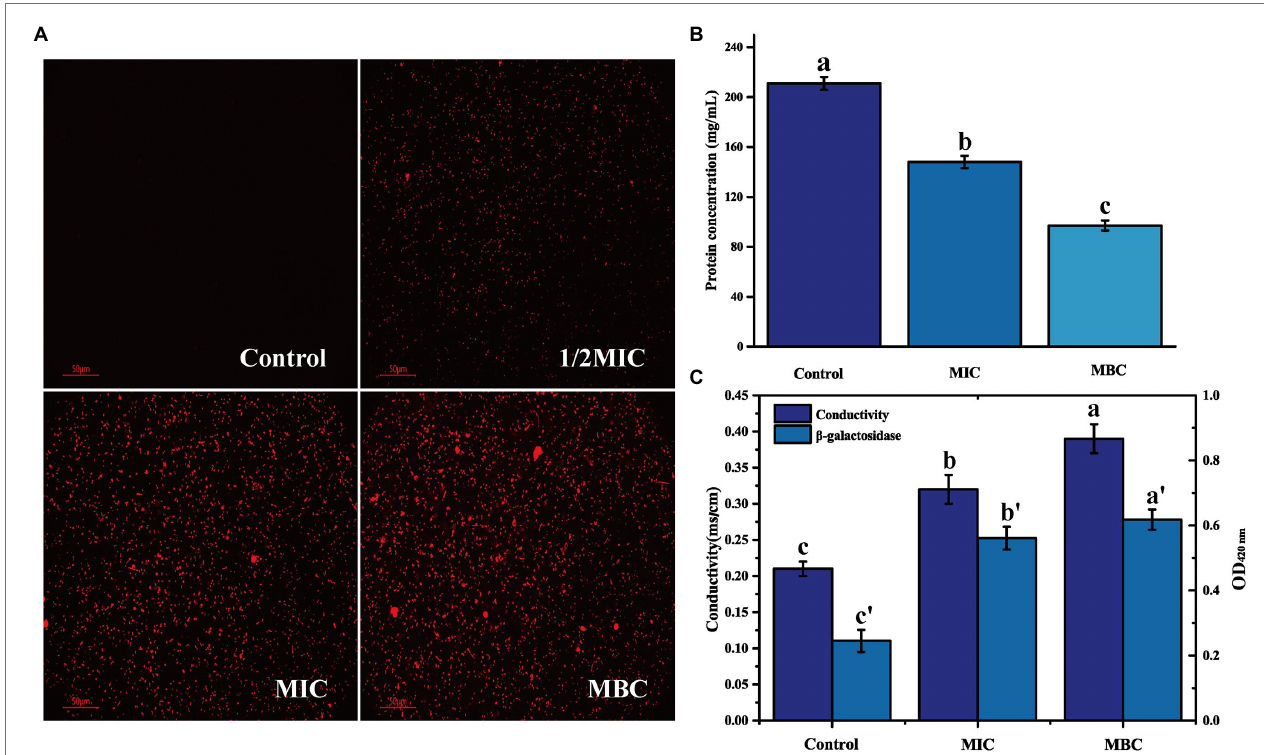
FIGURE 3 | The effect of BEO on the cell membrane permeability of L. monocytogenes : (A) Propidium iodide (PI) fluorescence picture; (B) Intracellular protein content; and (C) Changes of electrical conductivity and β -galactosidase. Different letters in the figure indicate significant difference ( p <